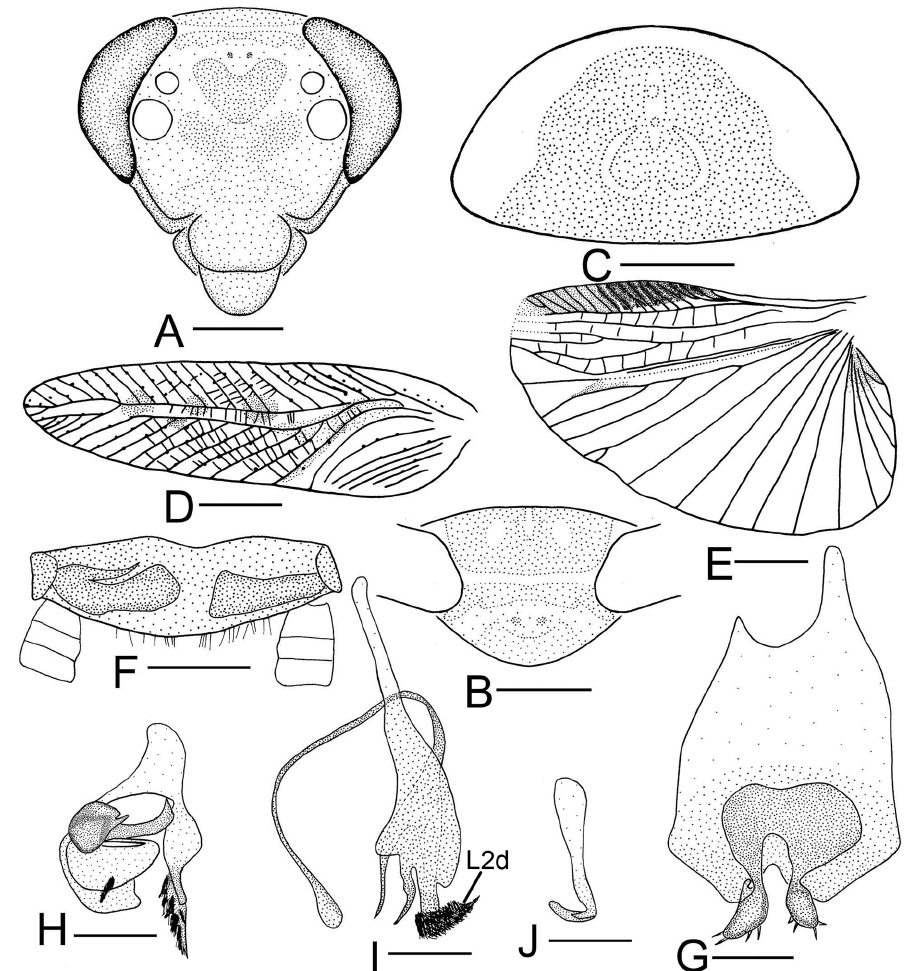
Figure 5. Sorineuchora undulata (Bey-Bienko, 1958) male from China, Yunnan, Xishuangbanna, Wang- tianshu. A head, frontal view B vertex C pronotum D tegmen E hind wing (the dotted line indicates wing fold) F supra-anal plate, ventral view G subgenital plate, dorsal view H phallomere L1 I phallomere L2vm and R3 J phallomere R2. Scale bars: 0.5 mm ( A, B, F–J ), 1.0 mm ( C ), 2.0 mm ( D, E